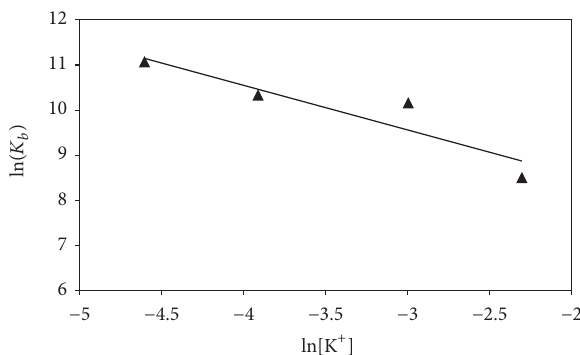
F 4: e effect of